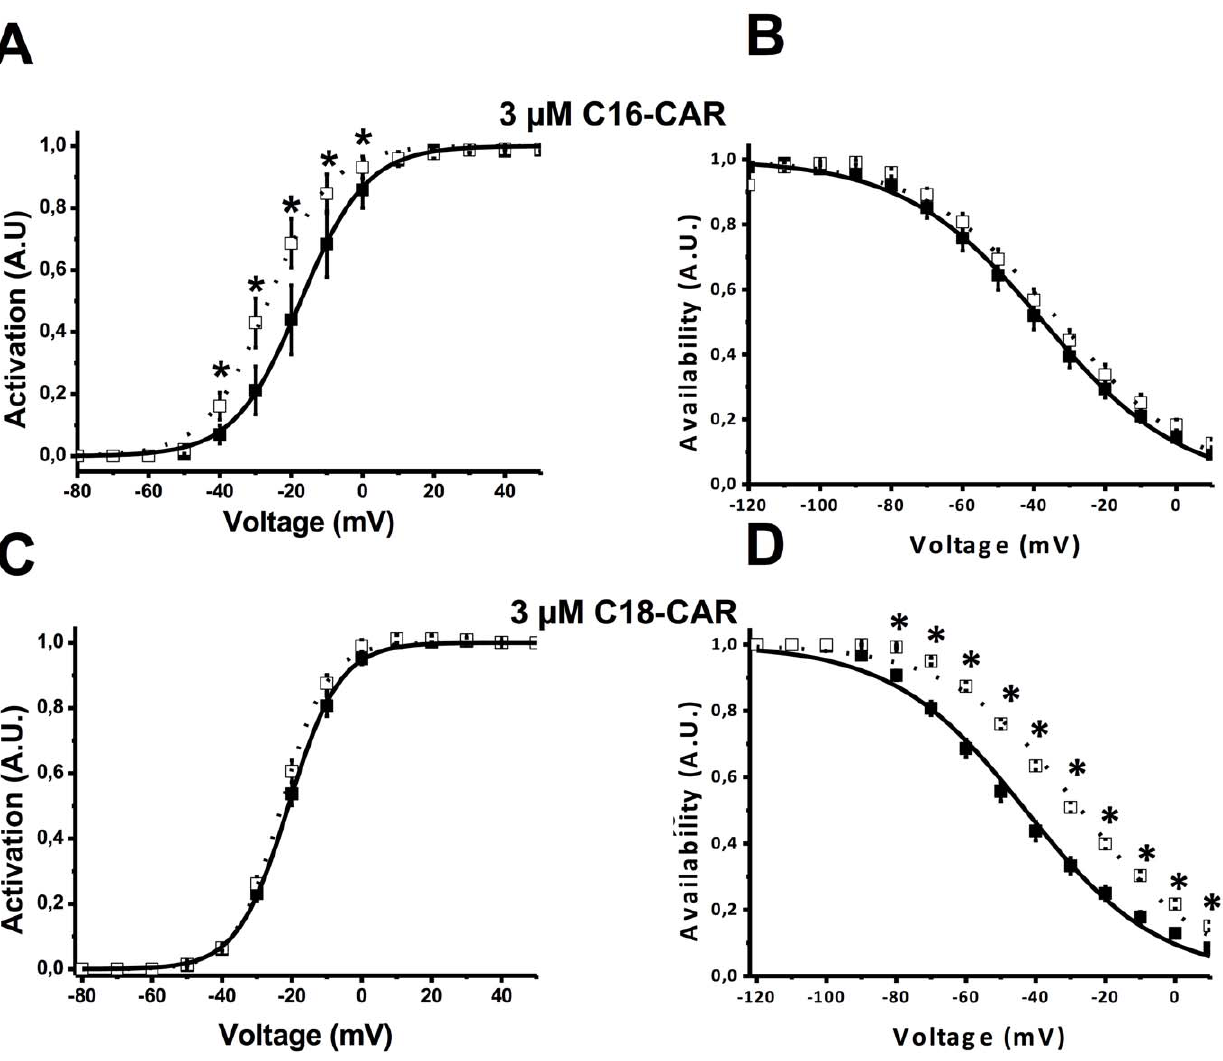
Figure 2. Effect of extracellular long-chain acyl-CARs on the activation and availability of the hERG current. A , effect of 3 m M C16-CAR on the activation curve. In the absence of C16-CAR (filled squares, n=6 cells), the V K is 2 17.4 6 0.2 mV while in the presence of 3 m M acyl-CAR (empty squares) the V K is 2 26.5 6 0.5 mV. B , effect of 3 m M C16-CAR on availability. In the absence of C16-CAR (empty squares, n=6 cells), the V K is 2 35.4 6 1.4 mV while in the presence of 3 m M acyl-CAR (filled squares) the V K is 2 37.4 6 0.5 mV. C , effect of 3 m M C18-CAR on activation. In the absence of C18-CAR (filled squares, n=7 cells), the V K is 2 21.0 6 0.1 mV while in the presence of 3 m M acyl-CAR (empty squares) the V K is 2 23.0 6 0.2 mV. D , effect of 3 m M C18-CAR on availability. In the absence of C18-CAR (filled squares, n=7 cells) the V K is 2 42.9 6 1.0 mV while in the presence of 3 m M acyl-CAR (empty squares) the V K is 2 27.0 6 1.0 mV. * : p , 0.01.